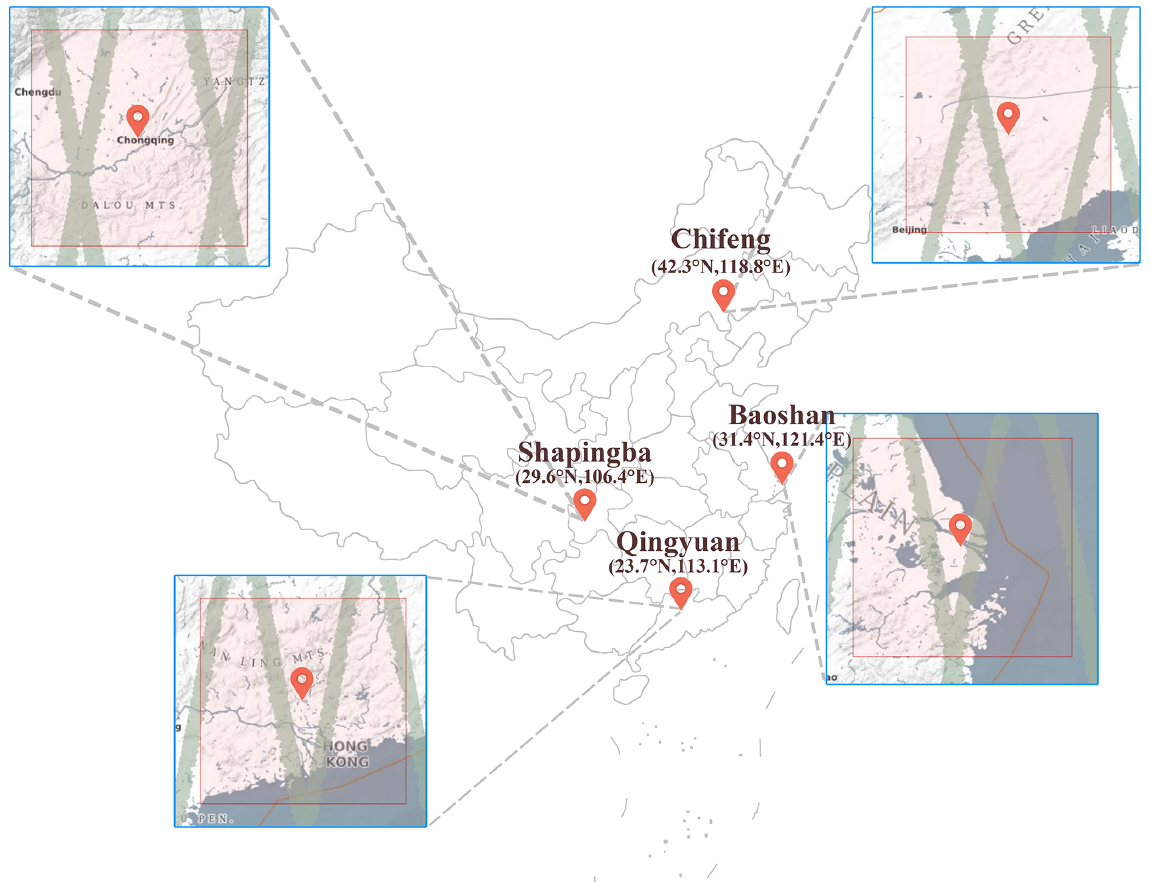
Figure 2. Geographical location of the L-band RS site and Aeolus measurement trajectory. In the enlarged view (http://aeolus-ds.eo.esa.int/ socat/L1B_L2_Products, last access: 27 July 2021), the red rectangles represent the range of ± 2 . 5 ◦ around the L-band RS stations, and the gray-green lines represent Aeolus’s overlapping trajectories for the 12 months.